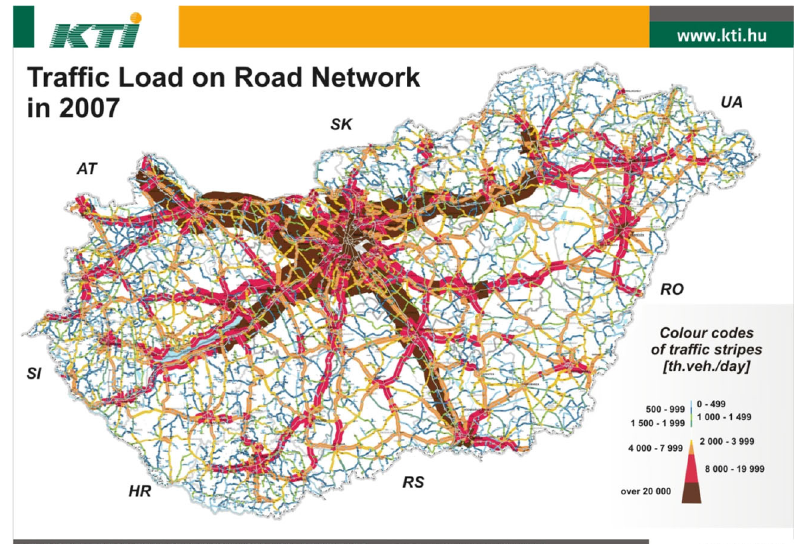
Fig. 4 Traffic Load on Road Network of Hungary in 2007 (Source: KTI)